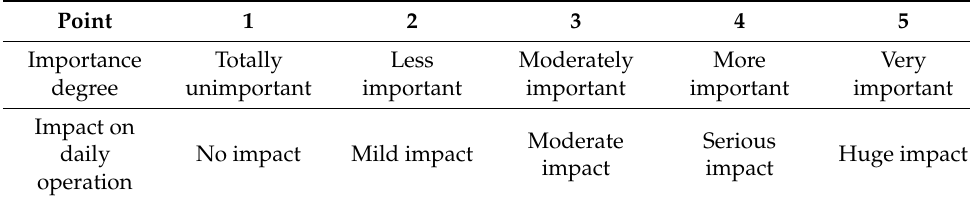
Table 1. Criteria for operating parameters importance